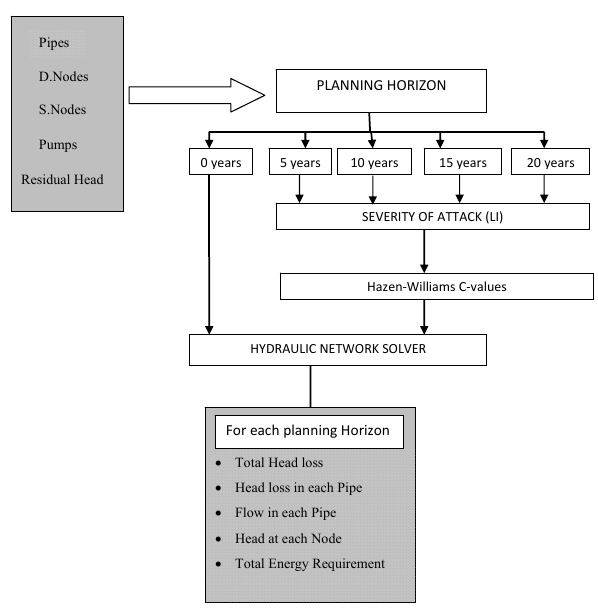
Figure 7. Schematic of planning Fig. 7. Schematic of Planning Module